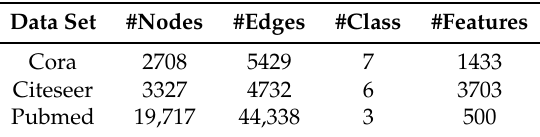
Table 1. Data set